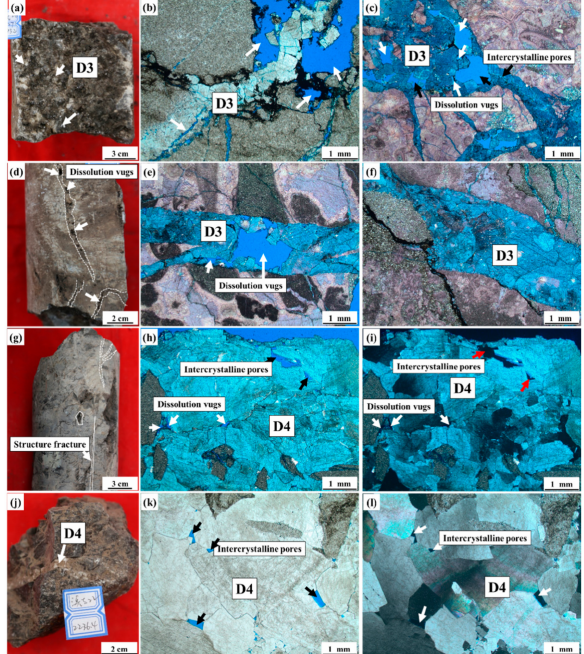
Figure 5. Petrological characteristics of the medium-to-coarse-crystalline dolomite cements (D3) and saddle dolomite (D4). ( a ) The medium-to-coarse-crystalline dolomite cements (D3) filled in the vertical fractures, and there is an obvious hydrocarbon charging phenomenon, Well Bg26 2793.2 m, Zhangxia formation, core; ( b ) microcrystalline dolomite; the developed dissolution fractures are filled in with medium-to-coarse-crystalline dolomite cements. The hydrocarbon dissolved the dolomite crystals and formed the dissolution vugs, shown by the white arrow, Well Bg22 2246.89 m, Ordovician formation, plane-polarized light; ( c ) bioclastic limestone; the medium-to-coarse-crystalline dolomite cements are filled in the structure fracture and formed the intercrystalline pores, shown by the black arrow. Some of the dolomite crystals were dissolved by the hydrocarbon and formed the dissolution vugs, shown by white arrow, Well Bg26 2793.2 m, Zhangxia formation, plane-polarized light; ( d ) the vertical fracture dissolved by the fluid and formed the dissolution vugs (shown by the white arrow), which are filled by coarse dolomite crystals, Well Bg26 2795.1 m, Zhangxia formation, core; ( e ) bioclastic limestone; structure fracture is developed and is filled in with medium-to-coarse- crystalline dolomite cements. Additionally, dolomite crystals are dissolved by fluid, forming the dissolution vugs (shown by white arrow), Well Bg26 2795.4 m, Zhangxia formation, plane-polarized light; ( f ) bioclastic limestone; medium-to-coarse-crystalline dolomite cements are tightly filled in the dissolution fractures. The dolomite crystals at the edge of the fracture are mainly medium-crystalline dolomite cements, while the size of the dolomite crystals at the center of the fracture increases gradually, Well Bg26 2798.2 m, Zhangxia formation, plane-polarized light; ( g ) microcrystalline dolomite; structural fractures developed, Well Bg22 2211.17 m, Ordovician formation, core; ( h ) microcrystalline dolomite; saddle dolomites are filled in the fracture, Well Bg22 2211.17 m, Ordovician formation, plane-polarized light; ( i ) saddle dolomites in the same view as h, perpendicular polarized light; ( j ) microcrystalline dolomite; high-angle structural fractures are filled by the saddle dolomites, Well Bg22 2236.4 m, Ordovician formation, core; ( k ) microcrystalline dolomite; characteristic of saddle dolomites are filled in fractures, and intercrystalline pores are formed by saddle dolomite crystals (the black arrow), Well Bg22 2246.89 m, Ordovician formation, plane-polarized light; ( l ) saddle dolomite in the same view as k, perpendicular polarized